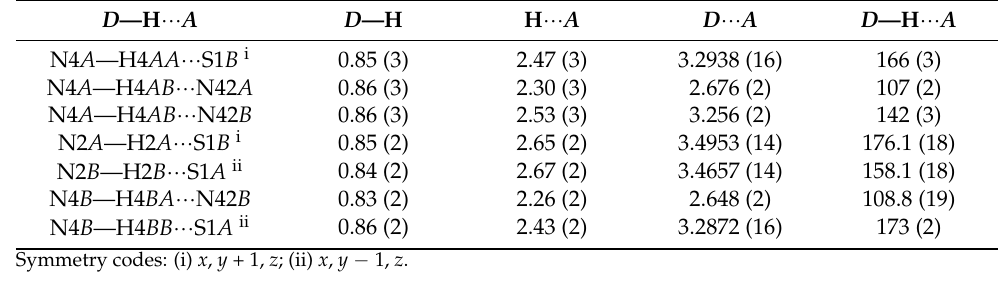
Table 3. Hydrogen-bond geometry (Å, ◦ ) for compound 1 .